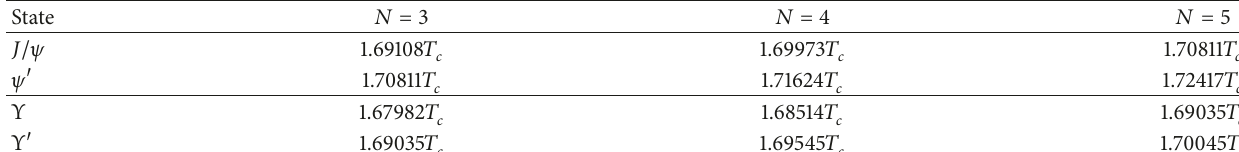
Table 3: The dissociation temperature 𝑇 𝐷 (MeV) at 𝜇 = 0.9 GeV with 𝑇 𝑐 = 160 MeV.